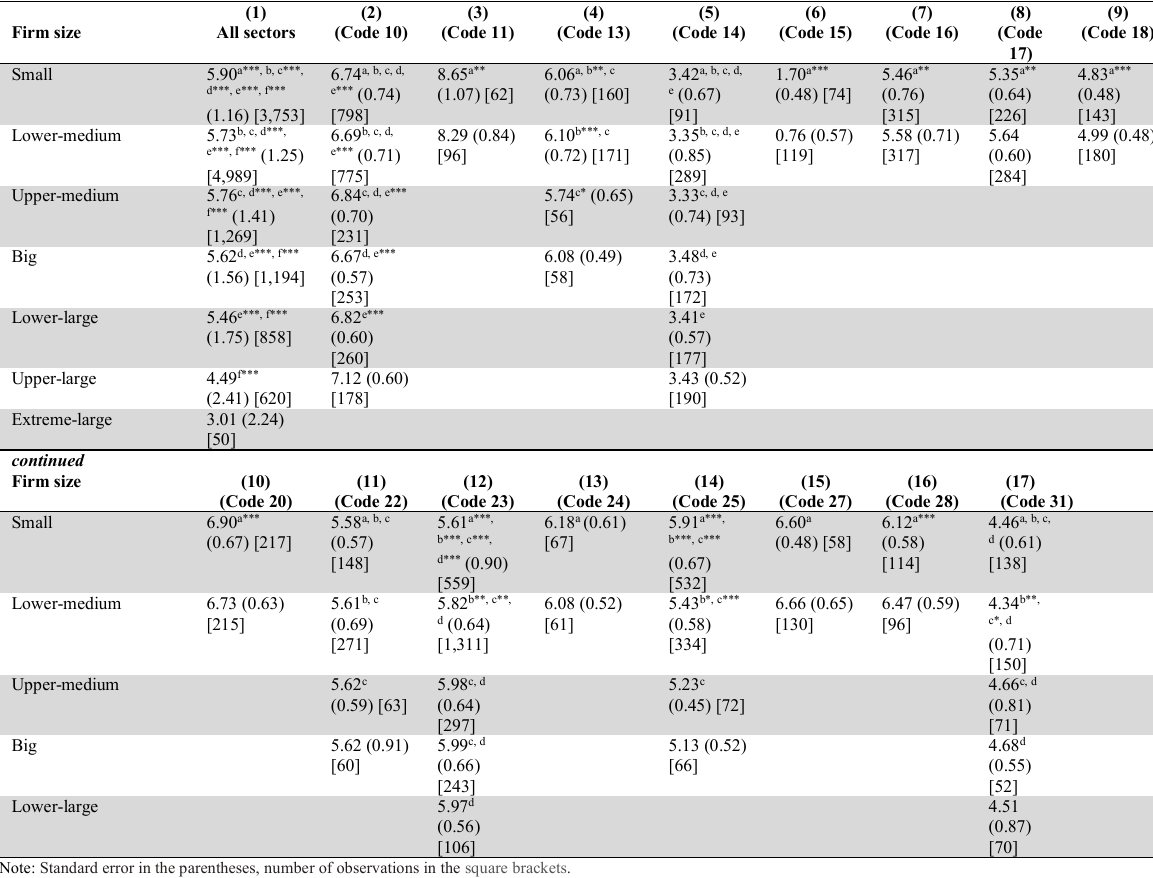
Labor heterogeneity in TFP distance (compare to top 1): Vietnamese manufacturing domestic private sector